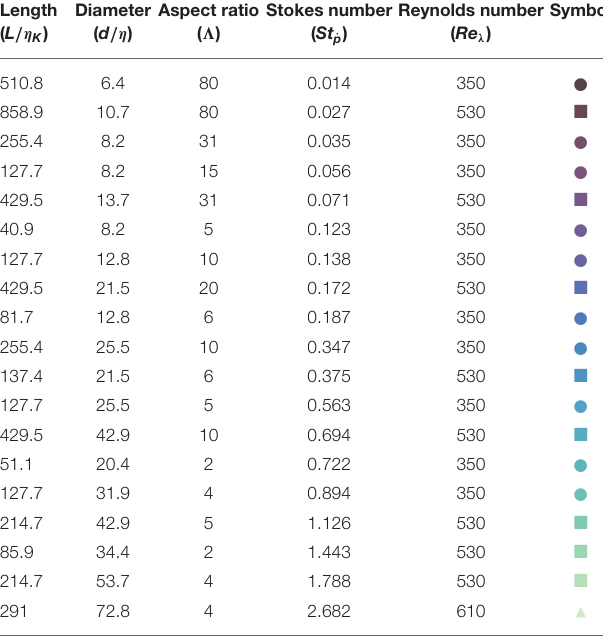
TABLE 1 | Characteristics of turbulence in the cube tank facility. Rotation frequency, f 5 Hz 10 Hz 15 Hz Reynolds number, Re λ 350 530 610 Kolmogorov lengthscale, η K 78.3 µ m 46.6 µ m 34.4 µ m Kolmogorov timescale, τ K 6.14 ms